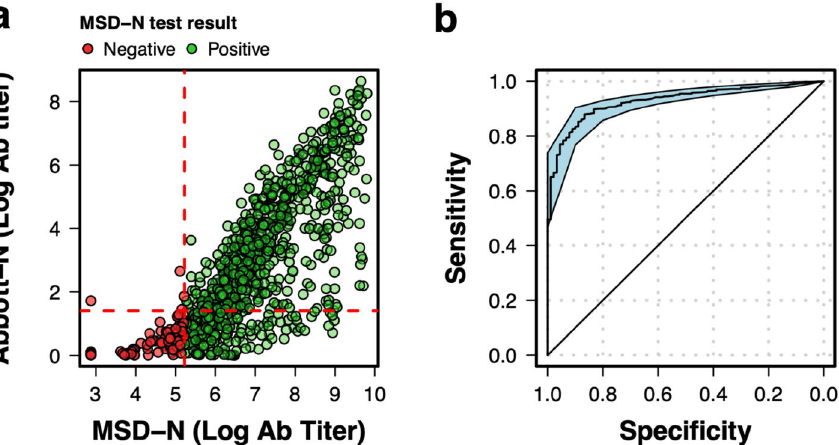
Figure 3. Comparison of antibody titers between the Abbott-N assay and the MSD-N assay. ( a ) The quantitative results for the MSD-N assay were compared to those of the Abbott-N test for each sample taken. Colours divide the samples depending on whether it was positive (green) or negative (red) for the MSD-N assay. Dotted red lines represent the seropositivity threshold for the Abbott-N assay (horizontal) and the MSD-N test (vertical). ( b ) ROC curve for the Abbott-N assay using the MSD-N test as gold standard. The x ~ y line represents the profile of a random classifier. Blue shaded area shows the 95%